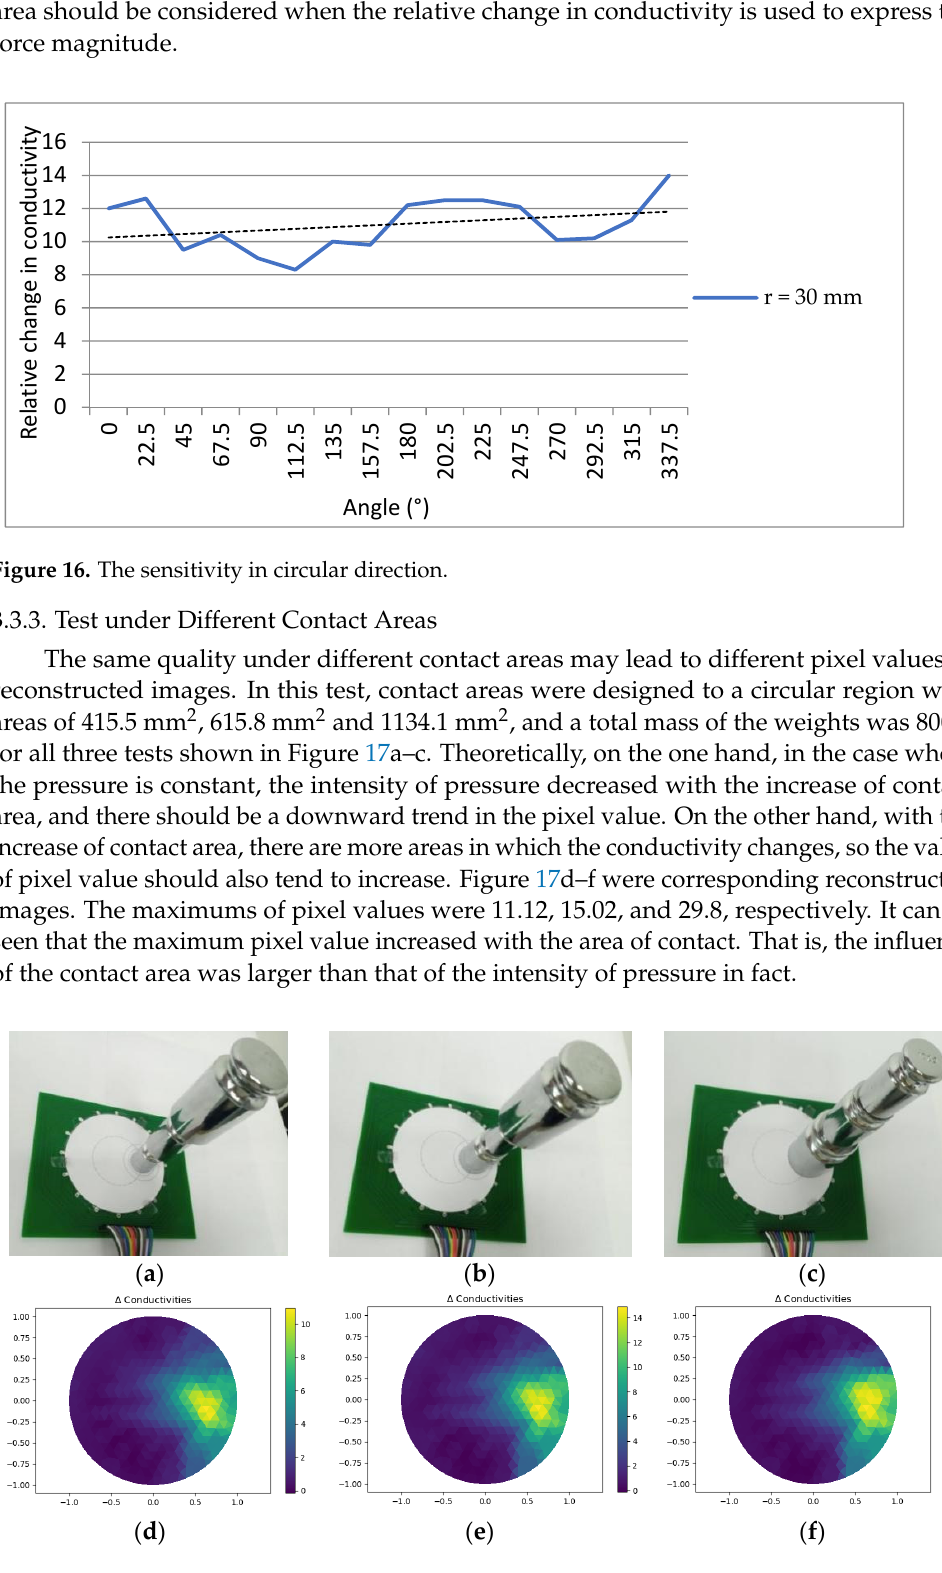
Figure 17. ( a ~ c ) Setup under different contact areas; ( d ~ f ) Reconstructed images.